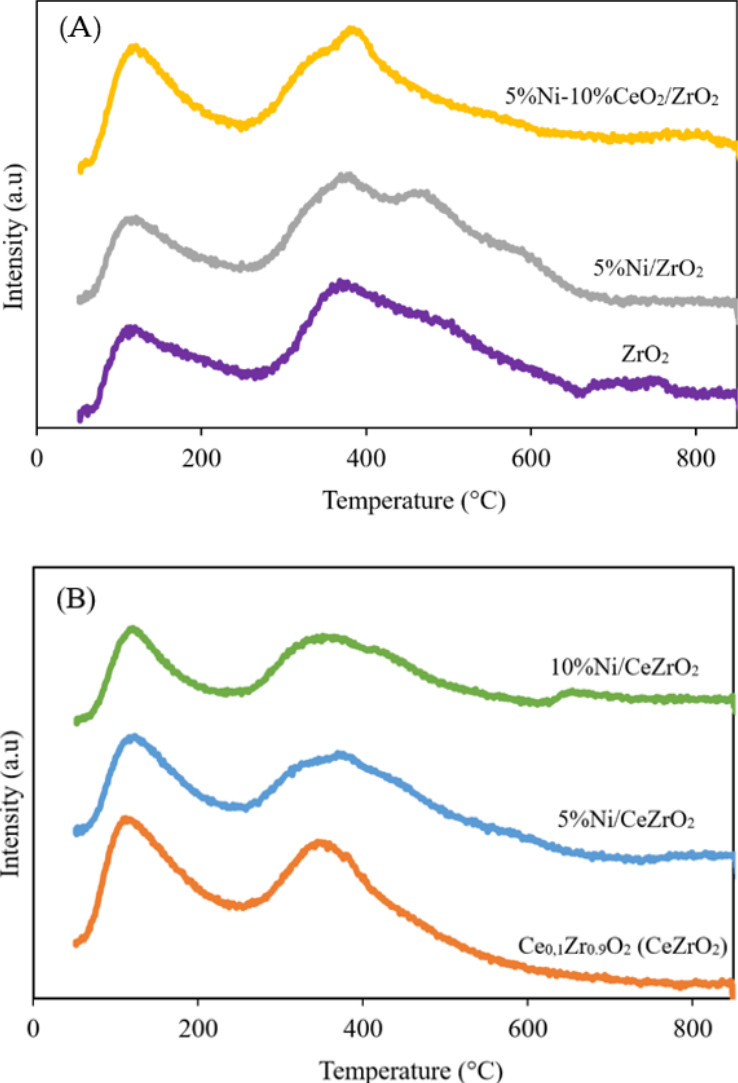
Figure 5. CO 2 -TPD profiles of catalyst: ( A ) ZrO2-supported Ni catalyst and ( B ) CeZrO2-supported Ni catalyst.